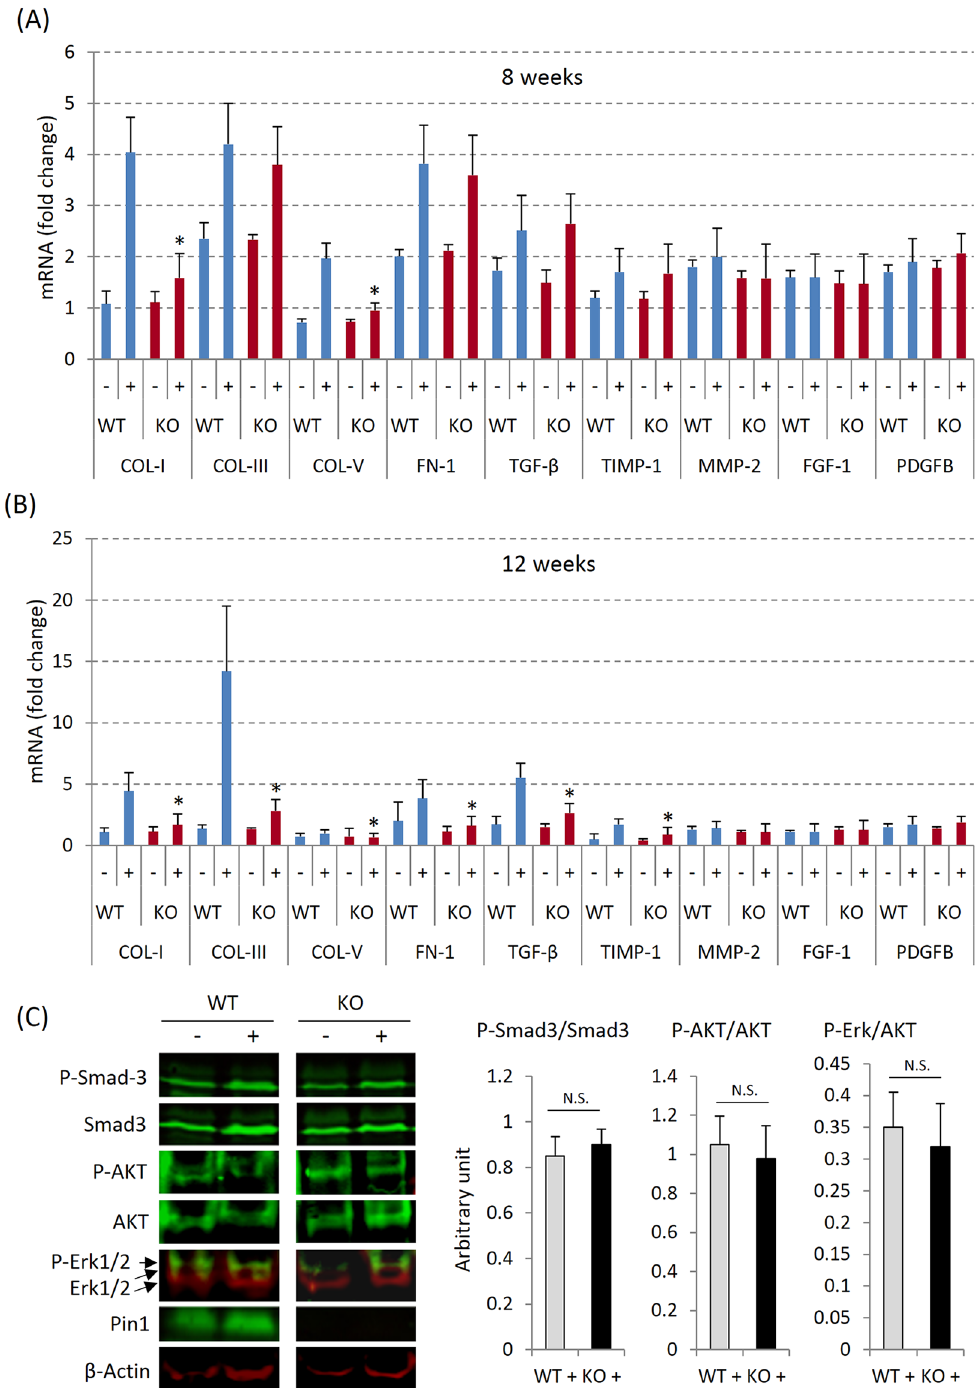
Fig 4. Renal Expression of ECM mRNAs. (A) and (B) Kidney RNA from 8- and 12-weeks HPD mice was subjected to quantitative PCR. * denotes p < 0.05 between genotypes with HPD (+) by student's t-test with 6 mice each group. (C) Whole kidney lysates from 12-weeks control and HPD mice were subjected to immunoblots with antibodies shown. The lysates were from 3 – 6 animals each group. Phosphorylated proteins were normalized to total proteins, and shown in bar graph (right). N.S. — not